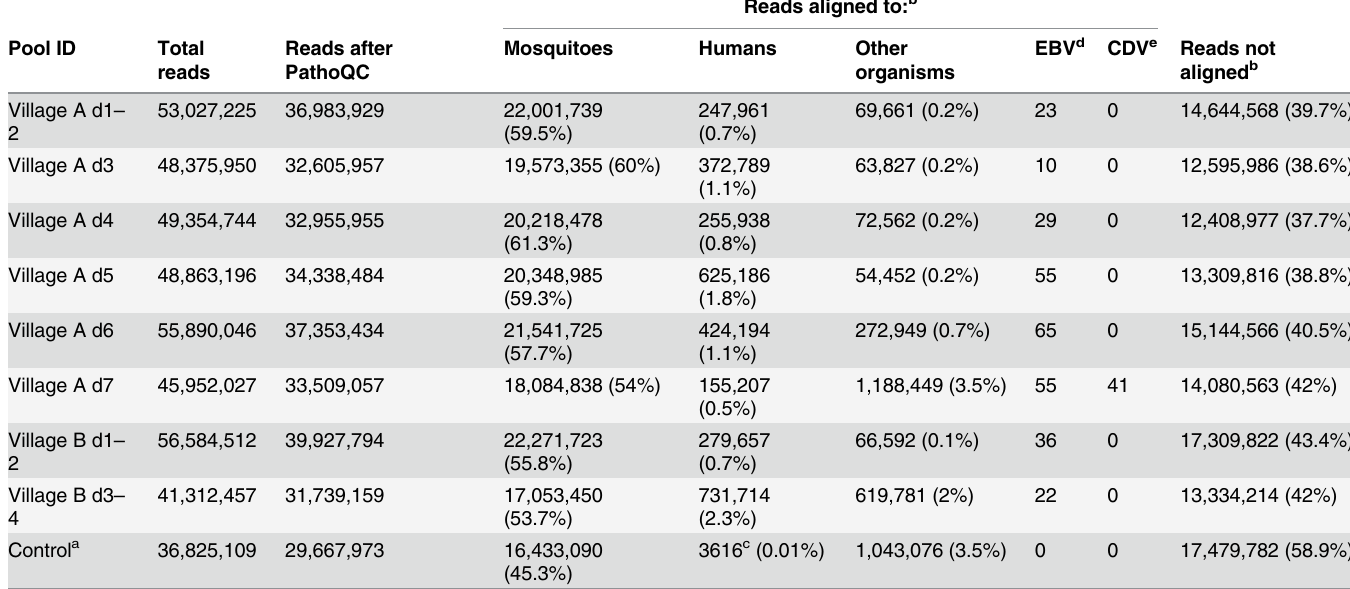
Reads aligned to: b